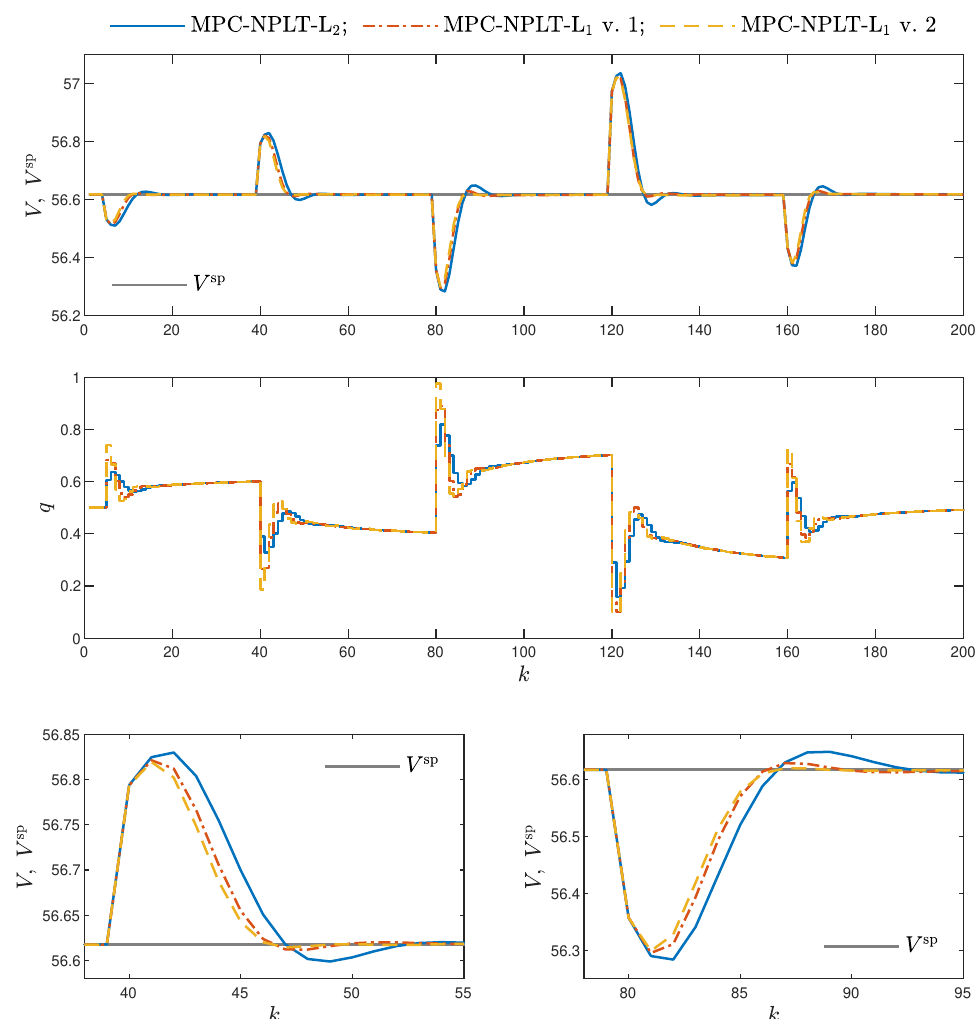
Figure 6. Simulation results: the MPC-NPLT-L 2 , MPC-NPLT-L 1 v. 1 and MPC-NPLT-L 1 v. 2